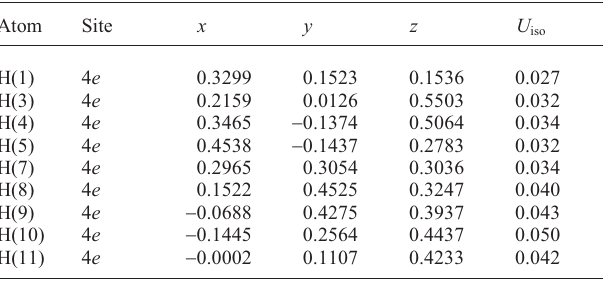
Table 2. Atomic coordinates and displacement parameters (in Å 2 )